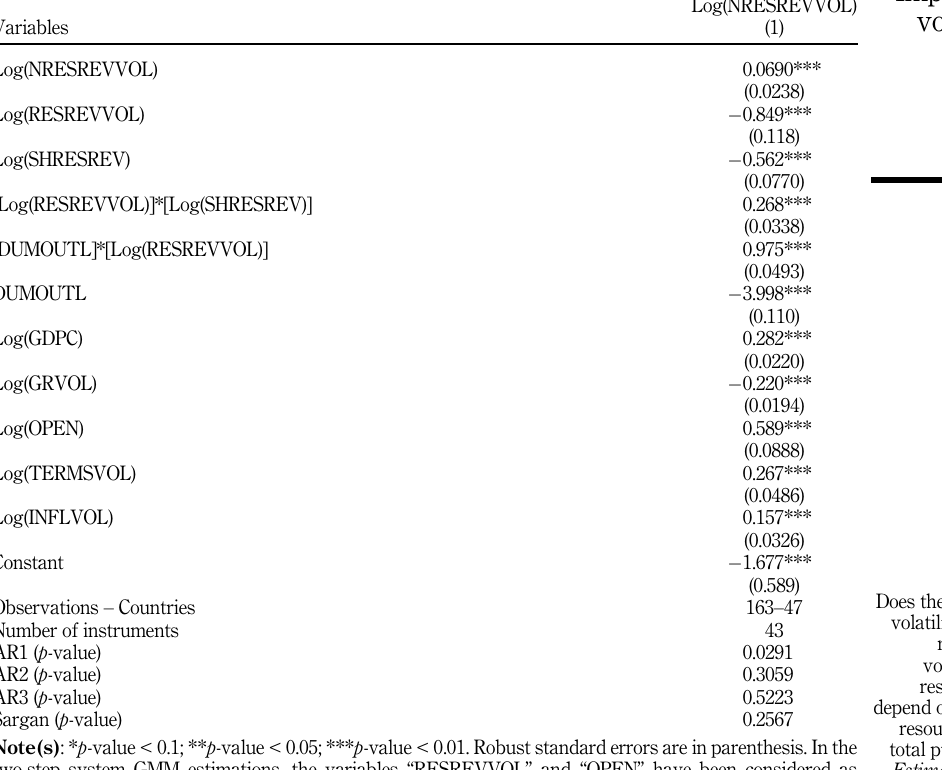
Table 3. Does the impact of